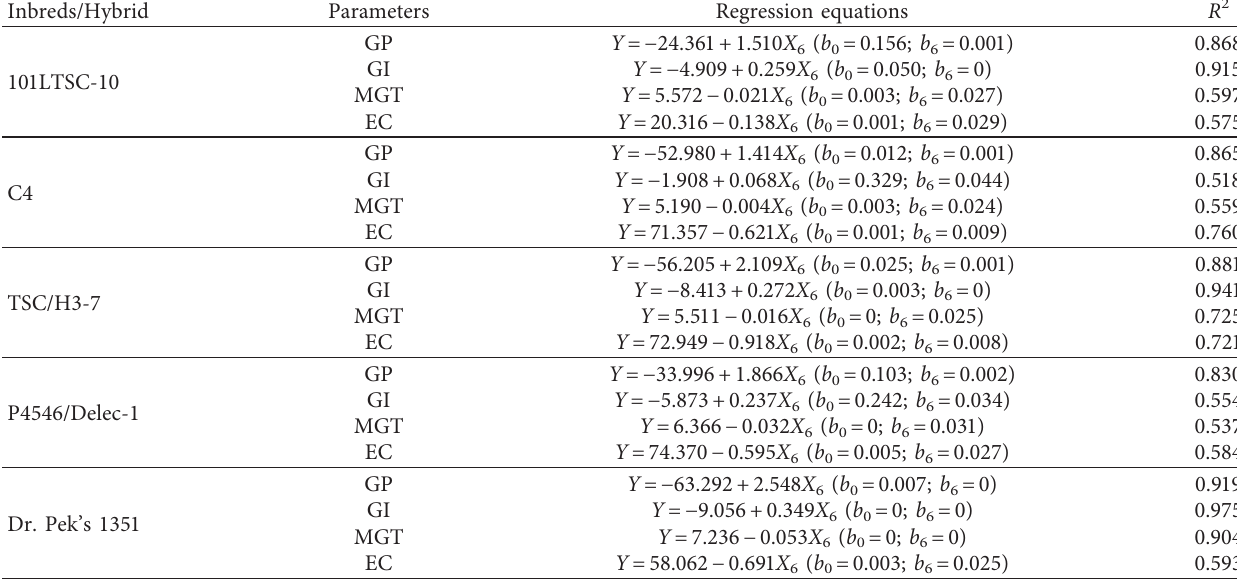
Table 3: Regression equations between seed quality and total starch contents in sweet corn seeds during seed development.